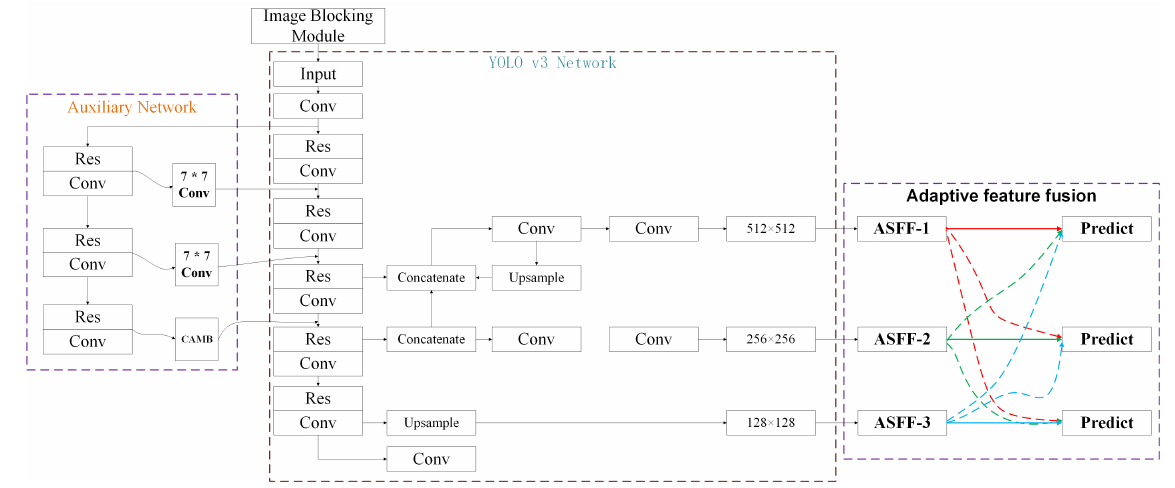
Figure 1. The overall pipeline of the method used in this paper.